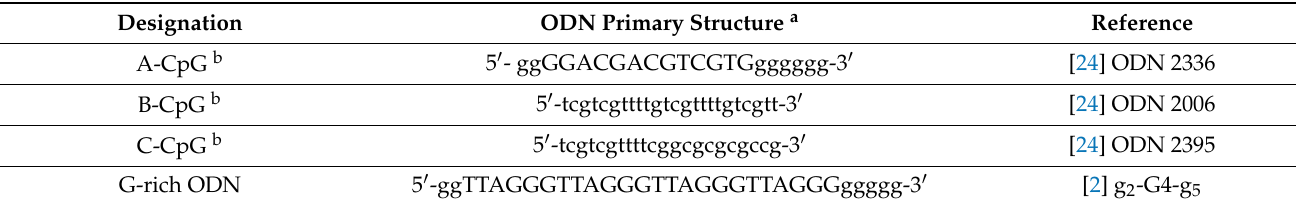
Table 1. Sequences and designations of oligodeoxyribonucleotides used in this